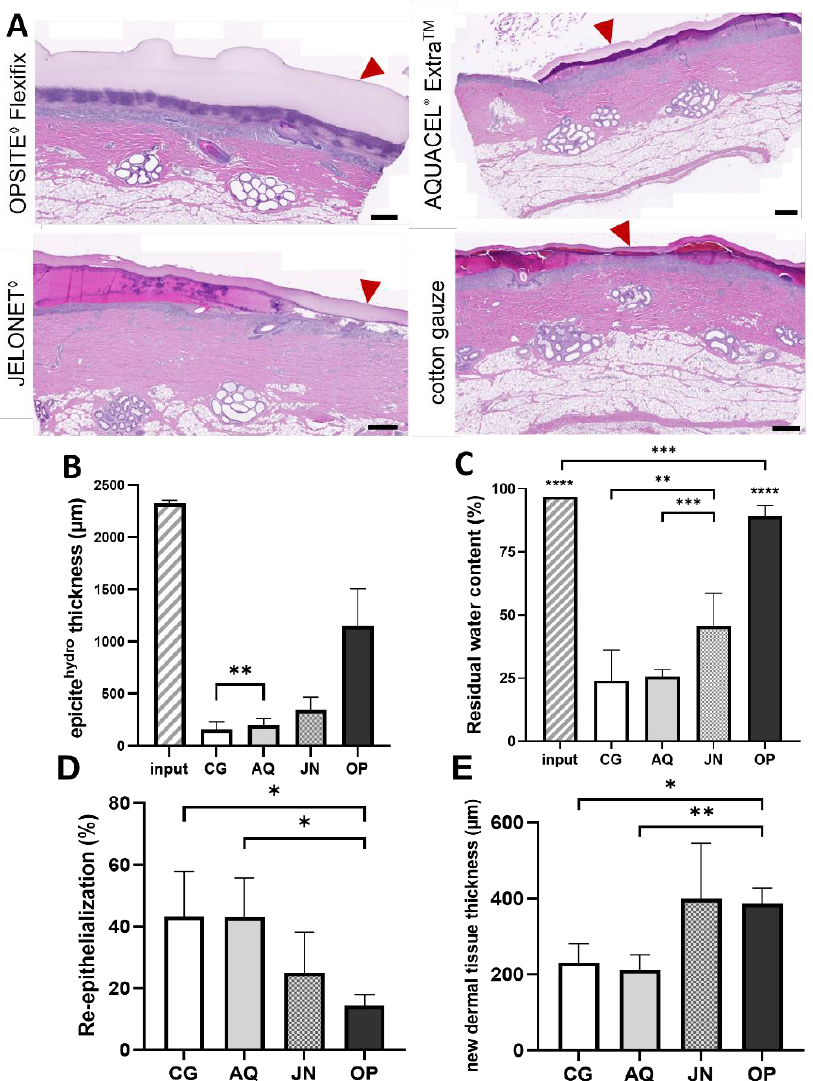
Figure 2. In vivo residual water analysis and healing process after five days of treatment. ( A ) H&E staining of punch biopsies extracted from the upper right area of the wound. Arrowheads highlight the remaining epicite hydro present on the wounded area. The scale bar represents 500 µ m. ( B ) Histogram of the thickness of the epicite hydro combined with secondary wound dressing on the surface of the wound after five days of treatment. Statistical significance was obtained between all comparisons ( p values: ** = 0.0037 and <0.001 for all other comparisons). ( C ) Histogram of relative residual water content of epicite hydro . All data were statistically different from input and from residual water of epicite hydro combined with OPSITE ◊ Flexifix. epicite hydro + cotton gauze and epicite hydro + AQUACEL ® Extra ™ showed differences in comparison with epicite hydro + JELONET ( p values: ****: <0.0001; ***: 0.0009/0.0004; **: 0.0026). ( D ) Percentage of re-epithelialization observed at the wound area. Re-epithelialization was higher on the wounds treated with epicite hydro + cotton gauze ♦ and epicite hydro + AQUACEL ® Extra ™ than on those treated with epicite hydro + OPSITE Flexifix ( p values: *: <0.05). ( E ) Average thickness of the new dermal tissue was obtained from the H&E slide ♦ measurement. Thicker tissue was formed on the wounds treated with epicite hydro + OPSITE Flexifix than on those treated with cotton gauze or AQUACEL ® Extra ™ as secondary dressing ( p values: * 0.0298; **: